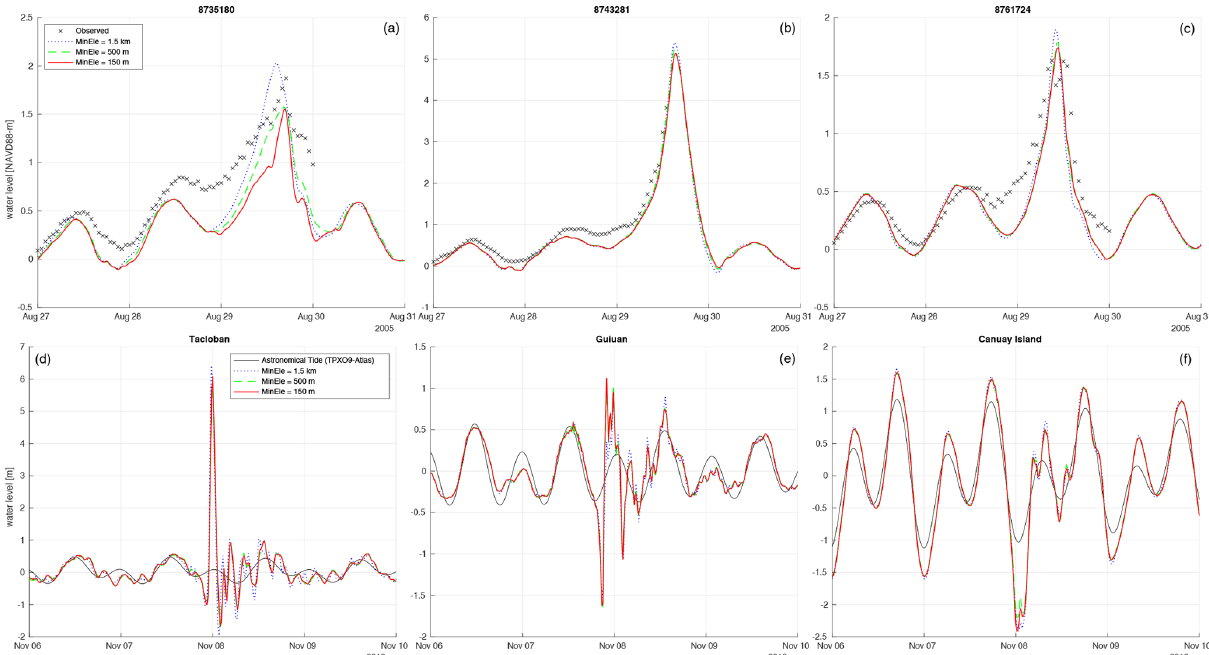
Figure 11. Comparisons of simulated storm tide elevation time series on meshes with different local MinEle (1.5km, 500m, 150m) at the point locations shown in Fig 9. (a–c) Hurricane Katrina compared to NOAA tide gauge observations (0.23m has been added to simulated results). (d–f) Super Typhoon Haiyan compared to the astronomical tide reconstructed from the TPXO9-Atlas.